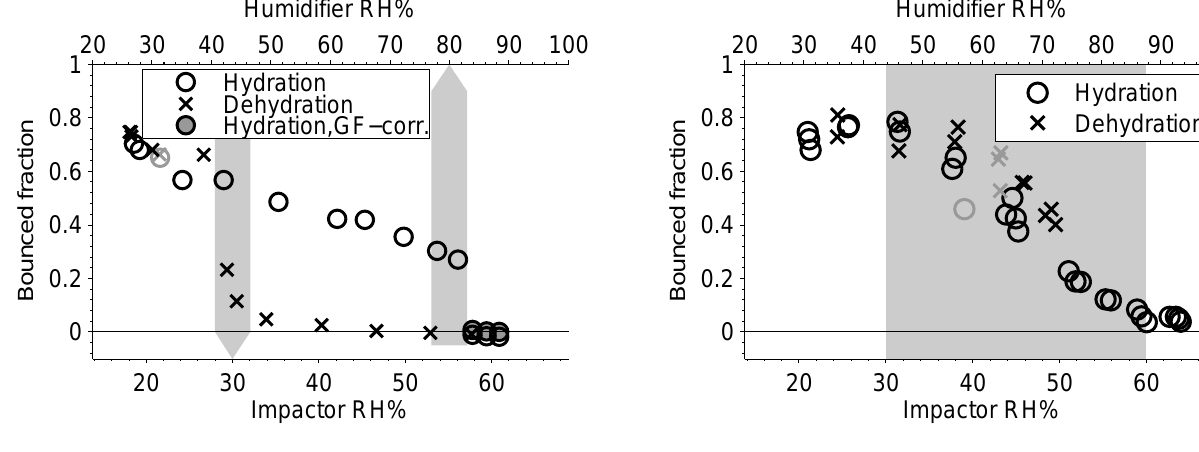
Fig. 4. Bounce fractions of ammonium sulfate aerosol at hydration and dehydration experiments. The GF-corrected points denote hy- dration points corrected for water uptake induced change in aerody- namic particle size as discussed previously. The first humidifier was kept at 90% RH for the ERH run. The arrows point at the efflores- cence and deliquescence relative humidities reported in Mikhailov et al. (2009). Bounced fraction is corrected according to Eq. 1. The gray symbols denote downscan points , to show the effect of loading of the substrate.